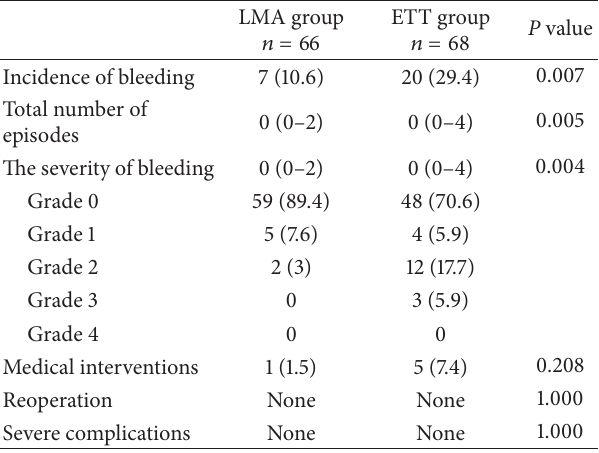
Table 1: Demographic and surgical characteristics. Table 2: Nasal bleeding conditions in the operation